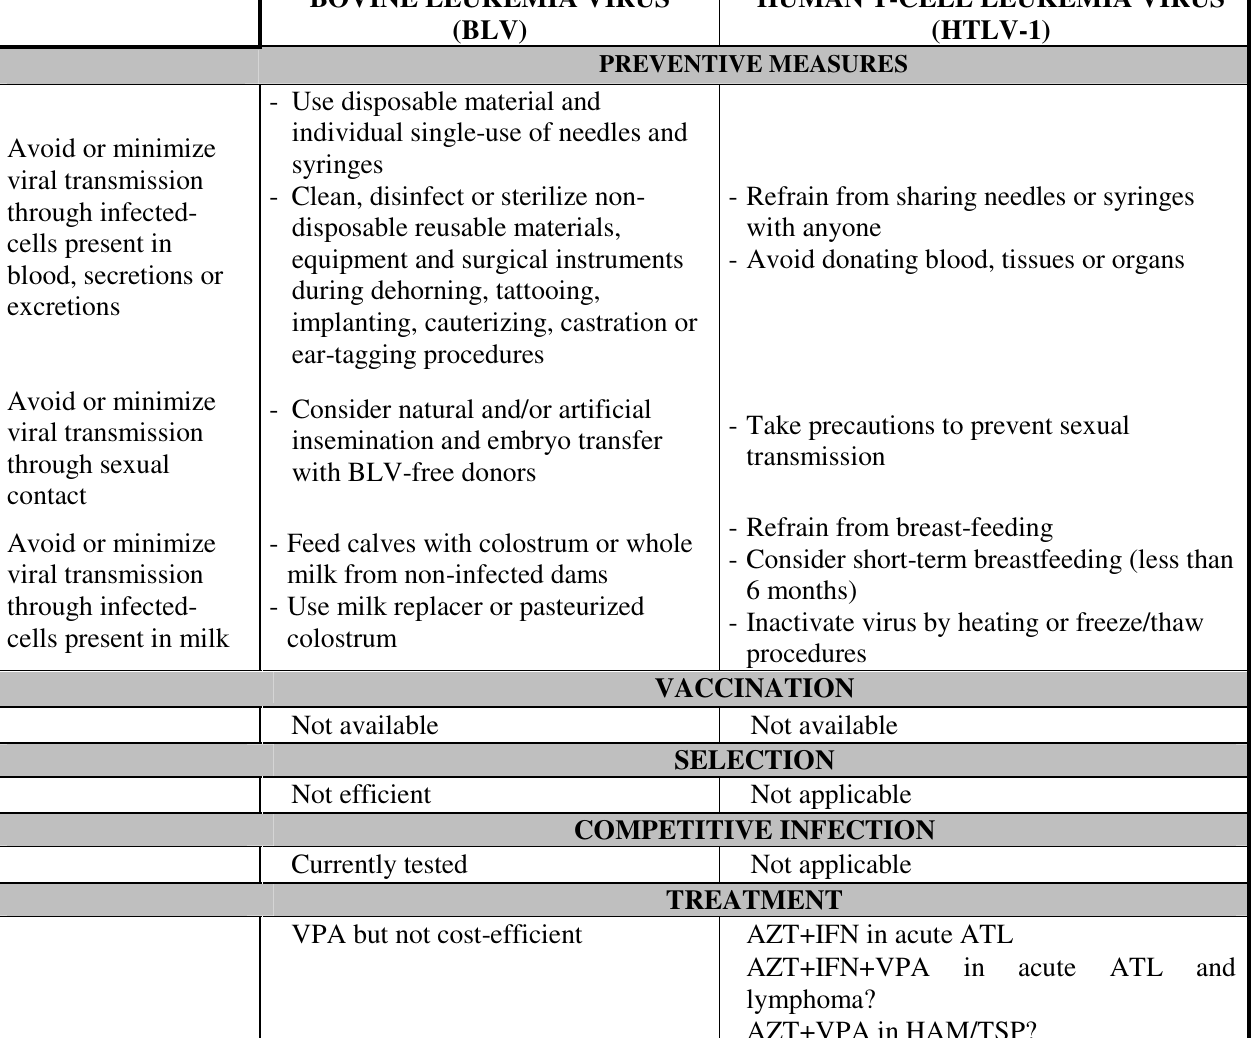
Table 2. Present and future prevention and treatment strategies for BLV and